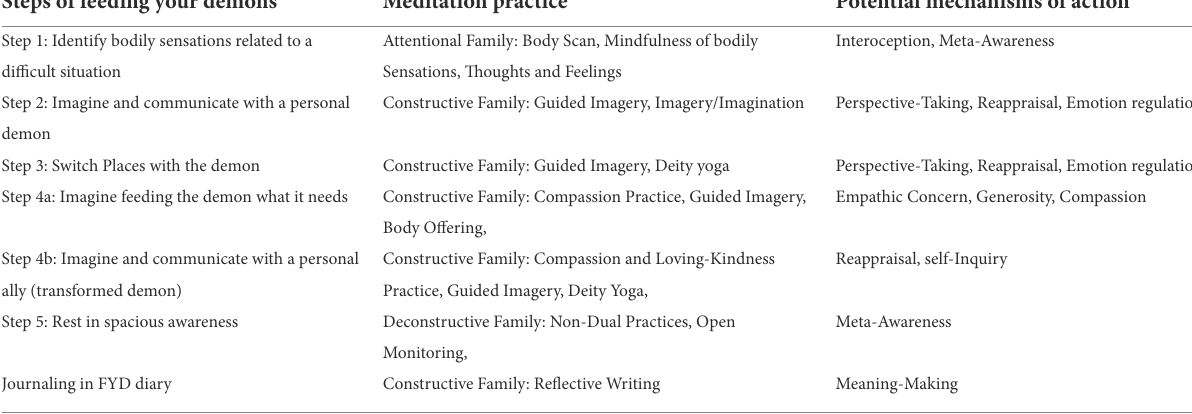
TABLE 1 FYD steps and related meditation practices, and potential mechanisms of action. Steps of feeding your